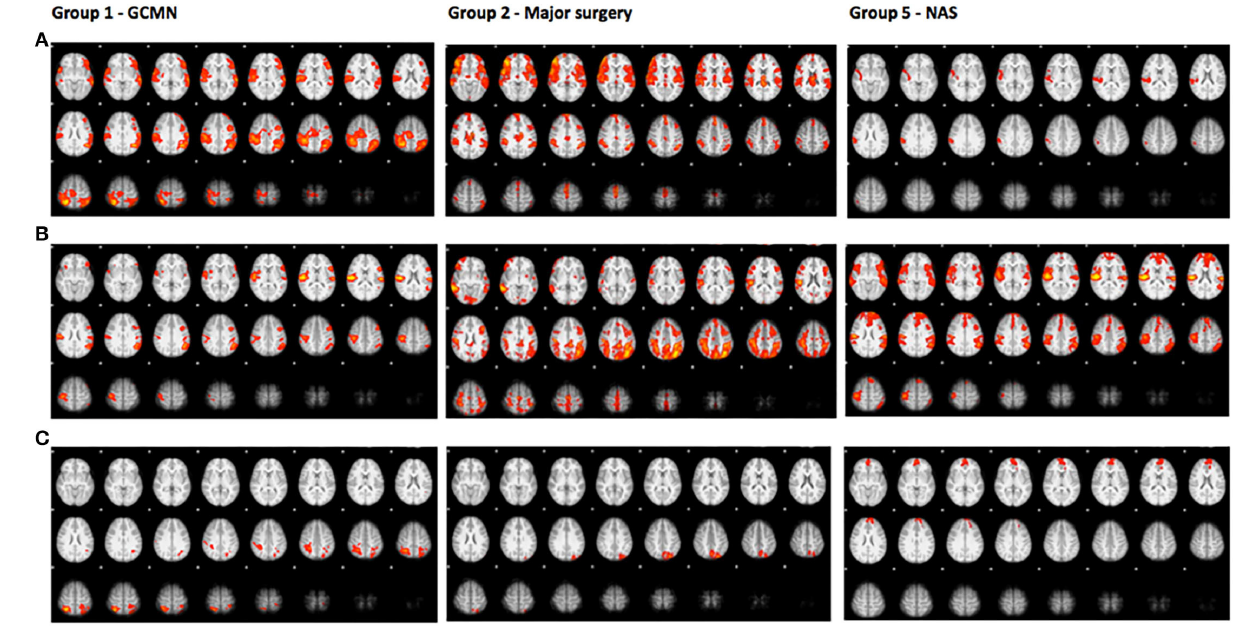
FIGURE 3 | Brain activation during